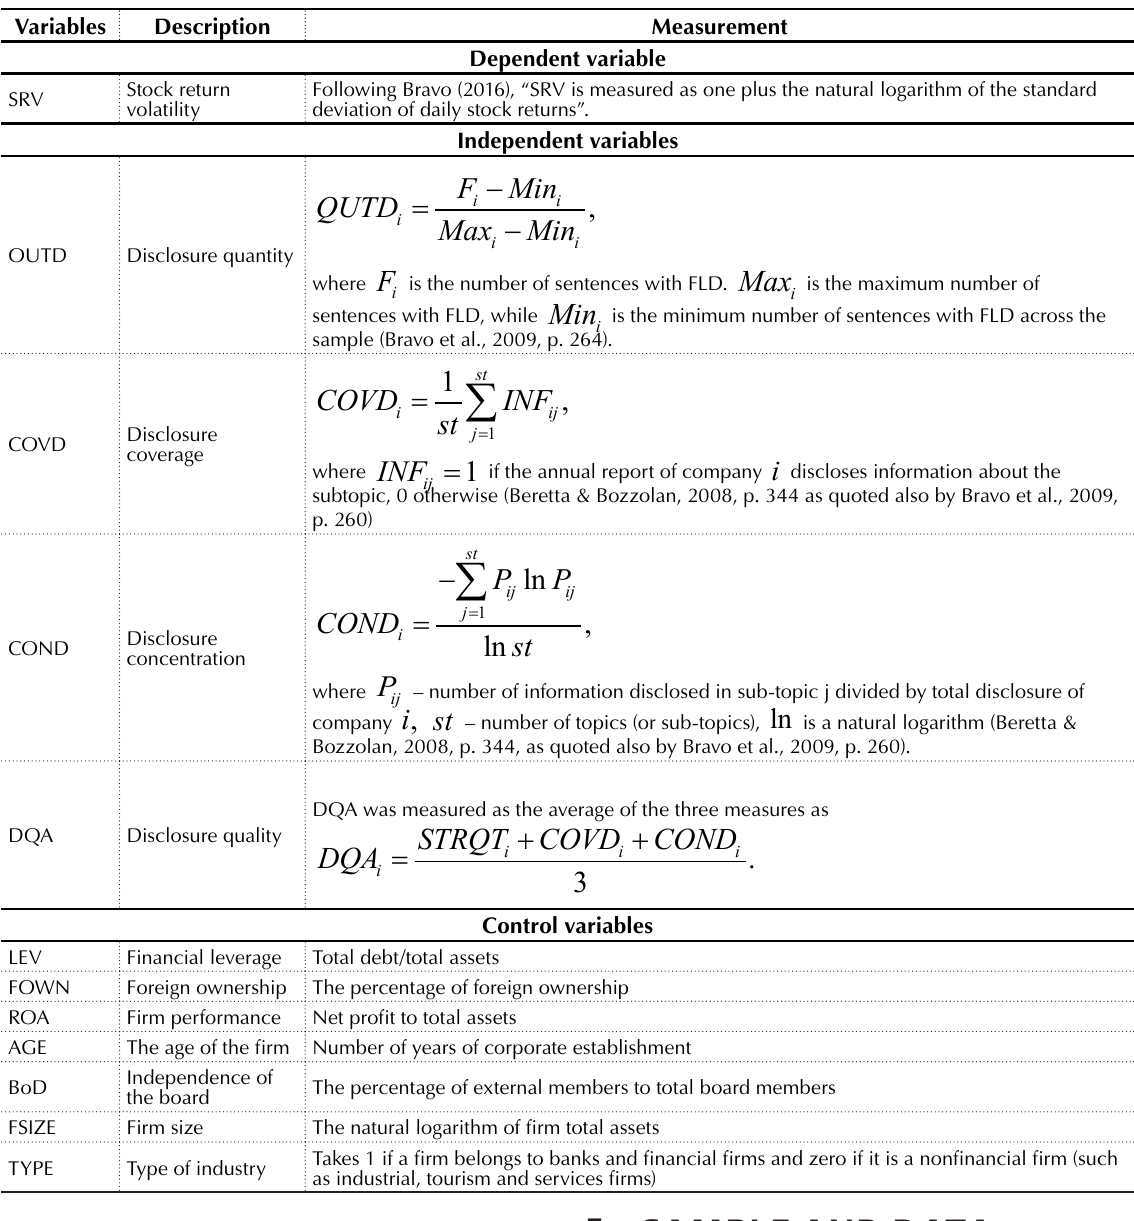
Table 1. Definitions of the study’s variables Variables